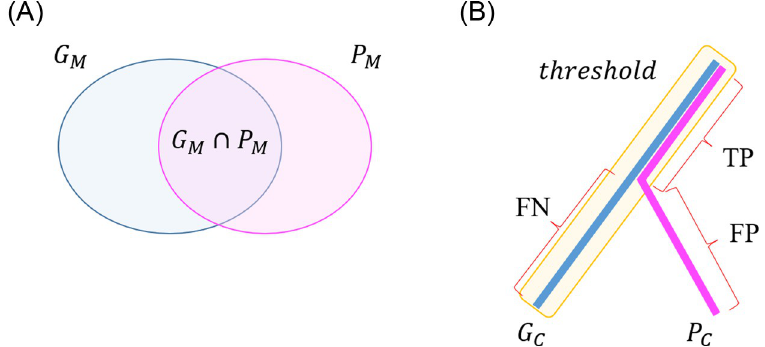
Fig 3. Evaluation of the accuracy of the extracted 3D images using the Dice coefficient. A The Dice similarity coefficient evaluates the matching rate of elements in two sets and is defined below, where TP means true positives, FP means false positives, and FN means false negatives. B The Dice similarity coefficient evaluates the matching rate of elements in two vessels data sets and is defined below, where Gc is the center voxel set of the correct mask, Pc is the center voxel set of the extracted mask, TP means true positives, FP means false positives, and FN means false